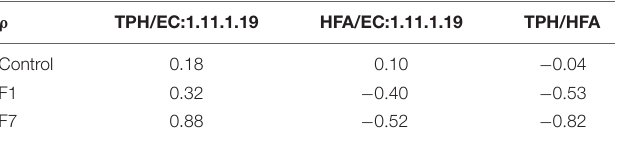
TABLE 1 | Spearman’s rank correlation coefficient for combination of DyP total counts per sample and relative TPH and HFA concentrations, separated per mesocosm